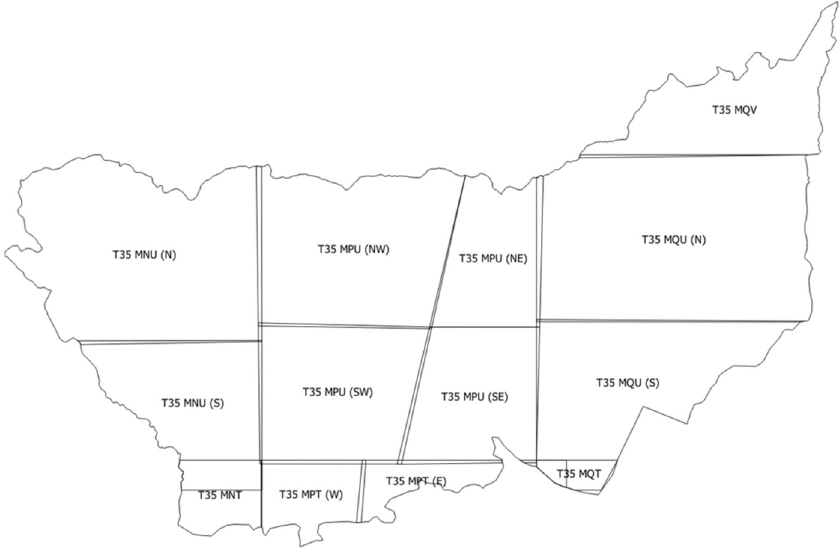
Figure 3. Division into subtiles of the AOI.